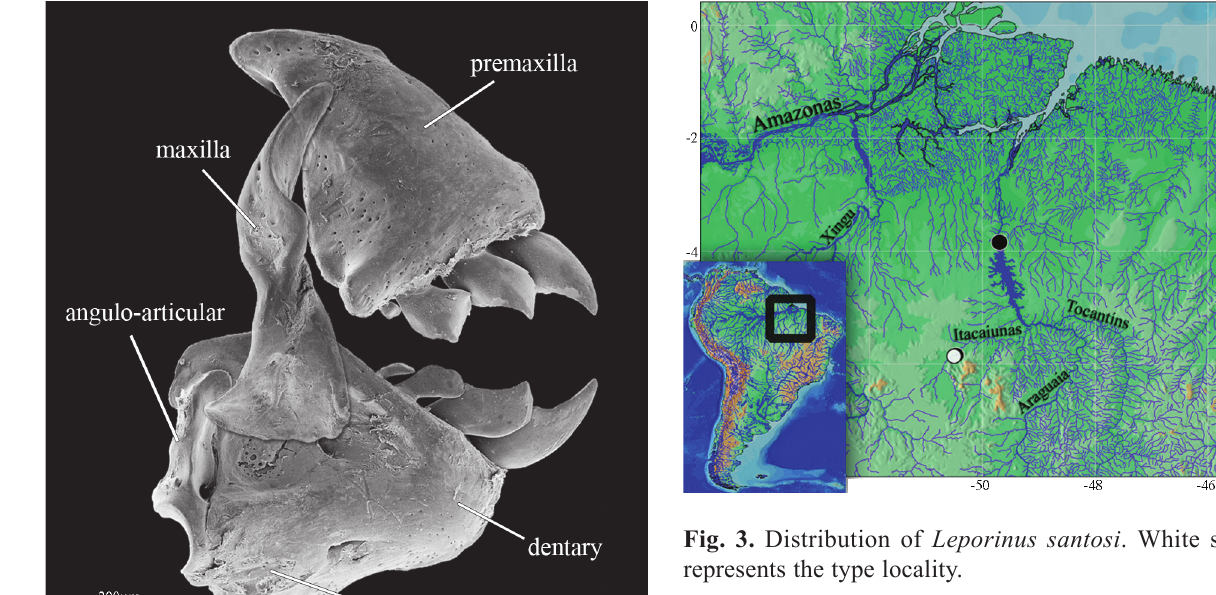
“X” between head and first midlateral blotch. In addition, center of each scale of anterolateral portion of body, between opercle and terminus of first midlateral blotch, with conspicuous dark spot formed by epidermal pigment; dark spots arranged in about eight longitudinal rows. Ventral